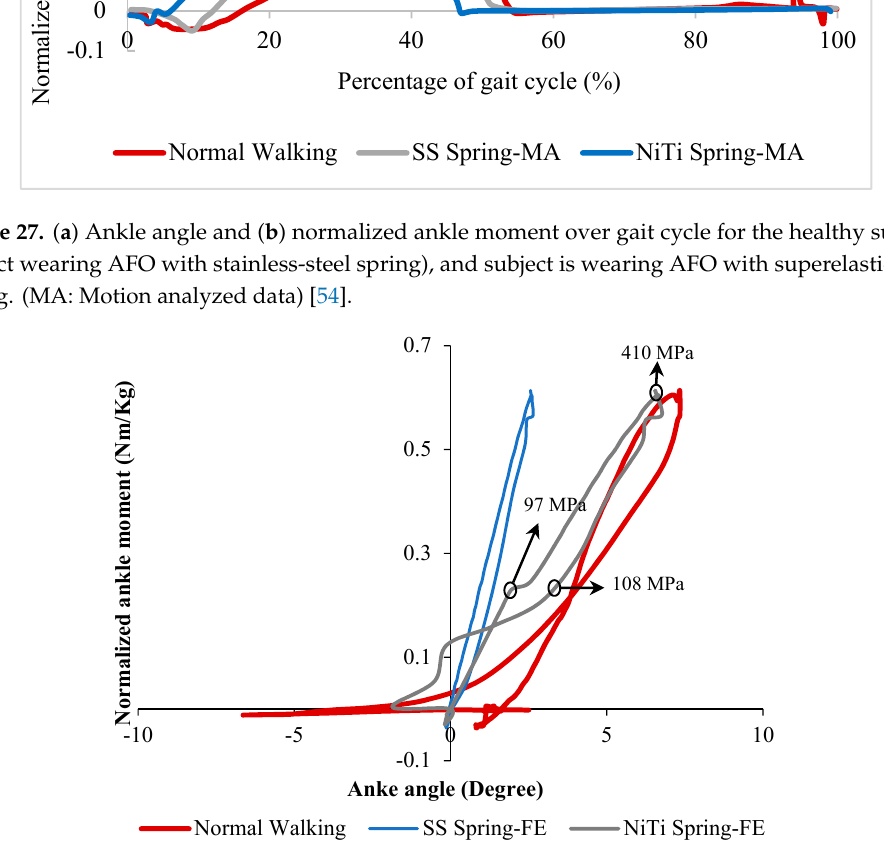
Figure 28. Ankle stiffness variation of drop foot patient with and without AFO [54].